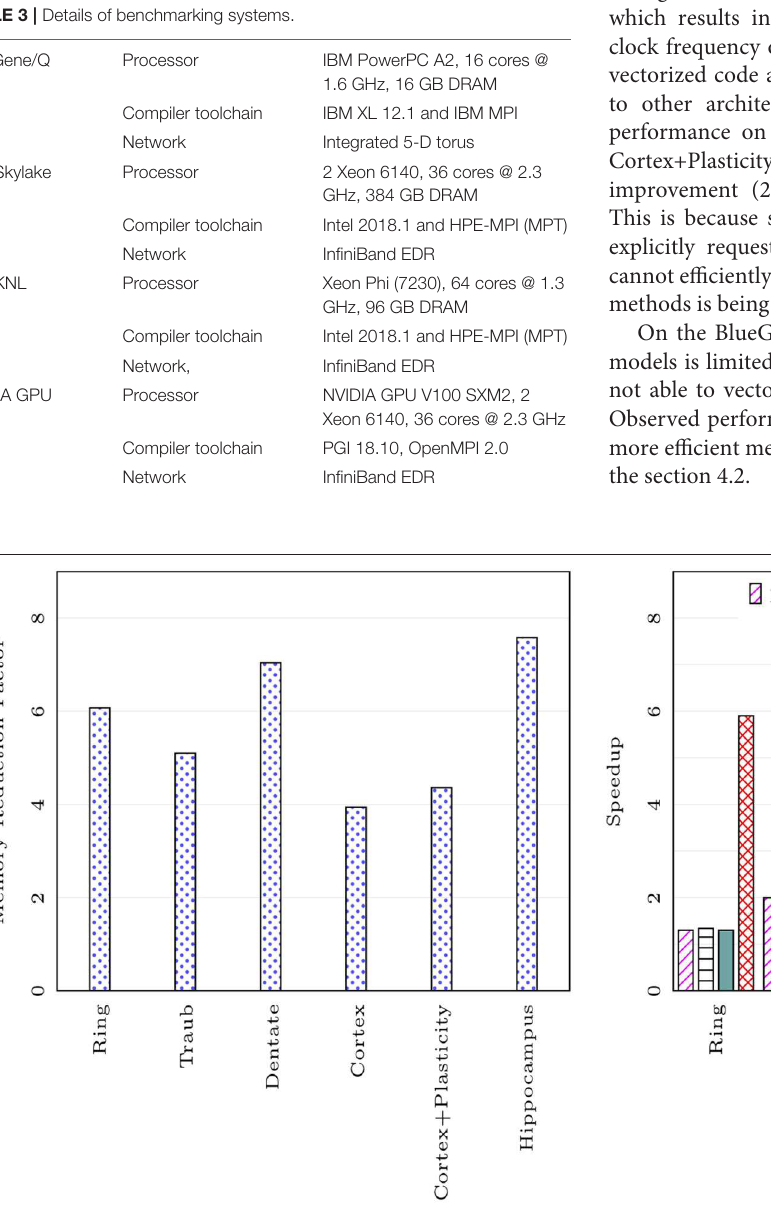
FIGURE 7 | Memory usage reduction and speedup using CoreNEURON : ratios of memory usage between NEURON and CoreNEURON for different models in Table 1 are shown on the left (measured on BB4 system). Speedups of CoreNEURON simulations compared to NEURON on various architectures (using single node) for the same models are shown on the